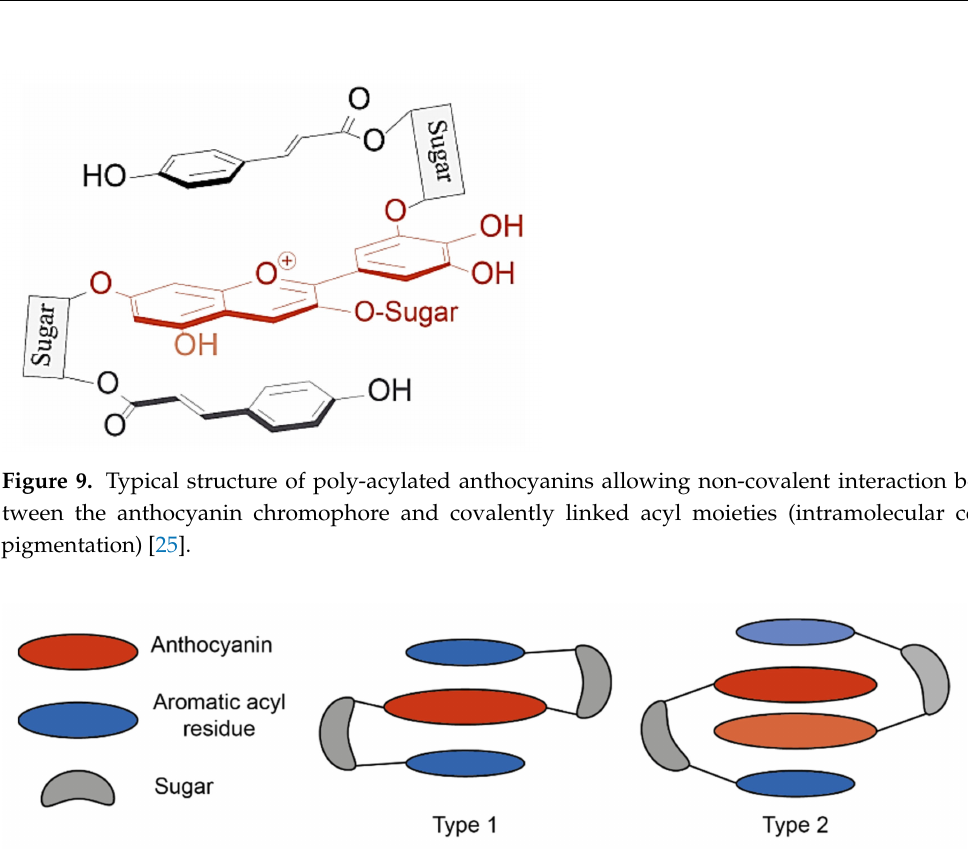
Figure 10. Simplified schematic of the two major types of intramolecular co-pigmentation. Type 1 complexes form intramolecular co-pigmentation interactions above and below the anthocyanin chromophore. Type 2 complexes form only one intramolecular interaction, and self-association interactions on the reverse plane. Adapted from